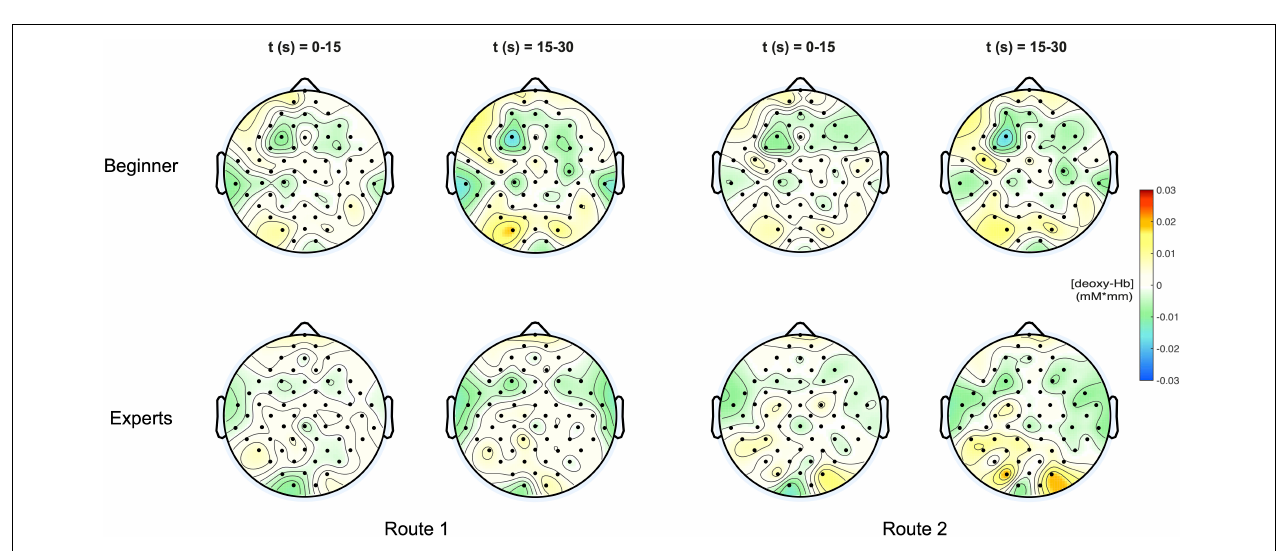
FIGURE 4 | (Top) Topoplots of the mean deoxy-Hb concentration changes for beginners during MI of both routes (left side: Route 1 = easy; right side: Route 2 = difficult) and two time windows (0–15 s and 15–30 s). (Bottom) Topoplots of the mean deoxy-Hb concentration changes for experts during MI of both routes (left side: Route 1 = easy; right side: Route 2 = difficult) and two time windows (0–15 s and 15–30 s).